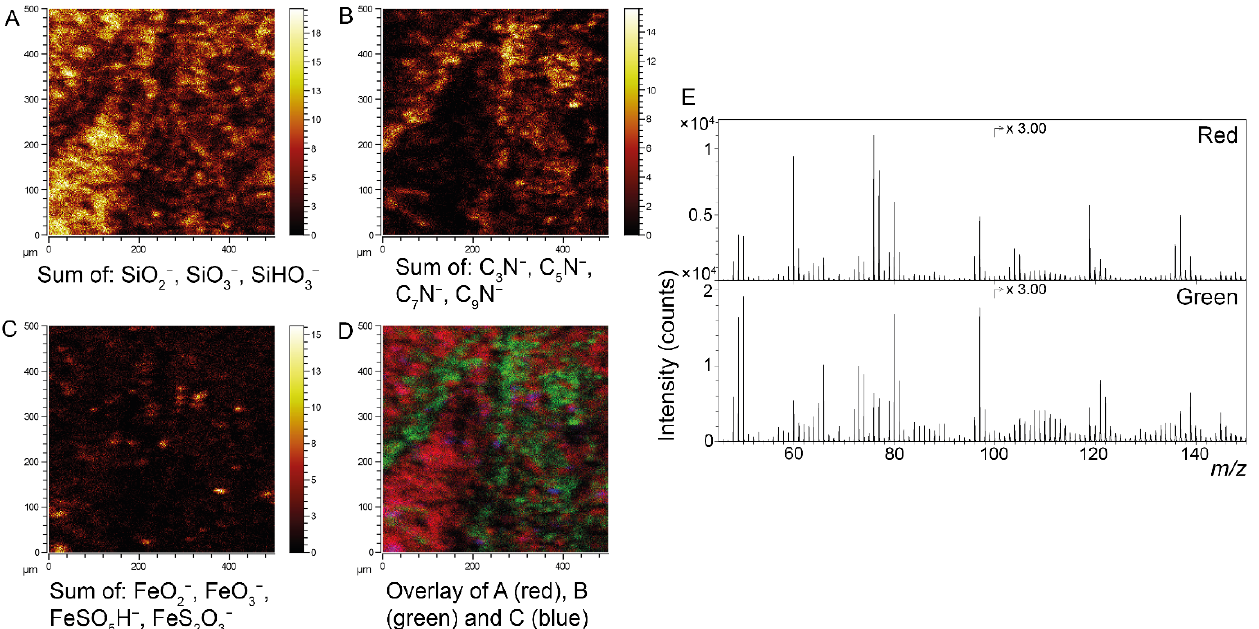
Figure 7. ToF-SIMS characterization of the fossil damselfly (FUM-N-10904). ( A – D ) Negative ion images representing ( A ) silica, ( B ) eumelanin and ( C ) iron oxide/sulfate, together with ( D ) an overlay image in which silica is presented in red, eumelanin in green and iron oxide/sulfate in blue. ( E ) Negative ion spectra from ROIs representing areas with high signal intensity from sediment-related ions (red; top) and eumelanin-associated ions (green; bottom), respectively.